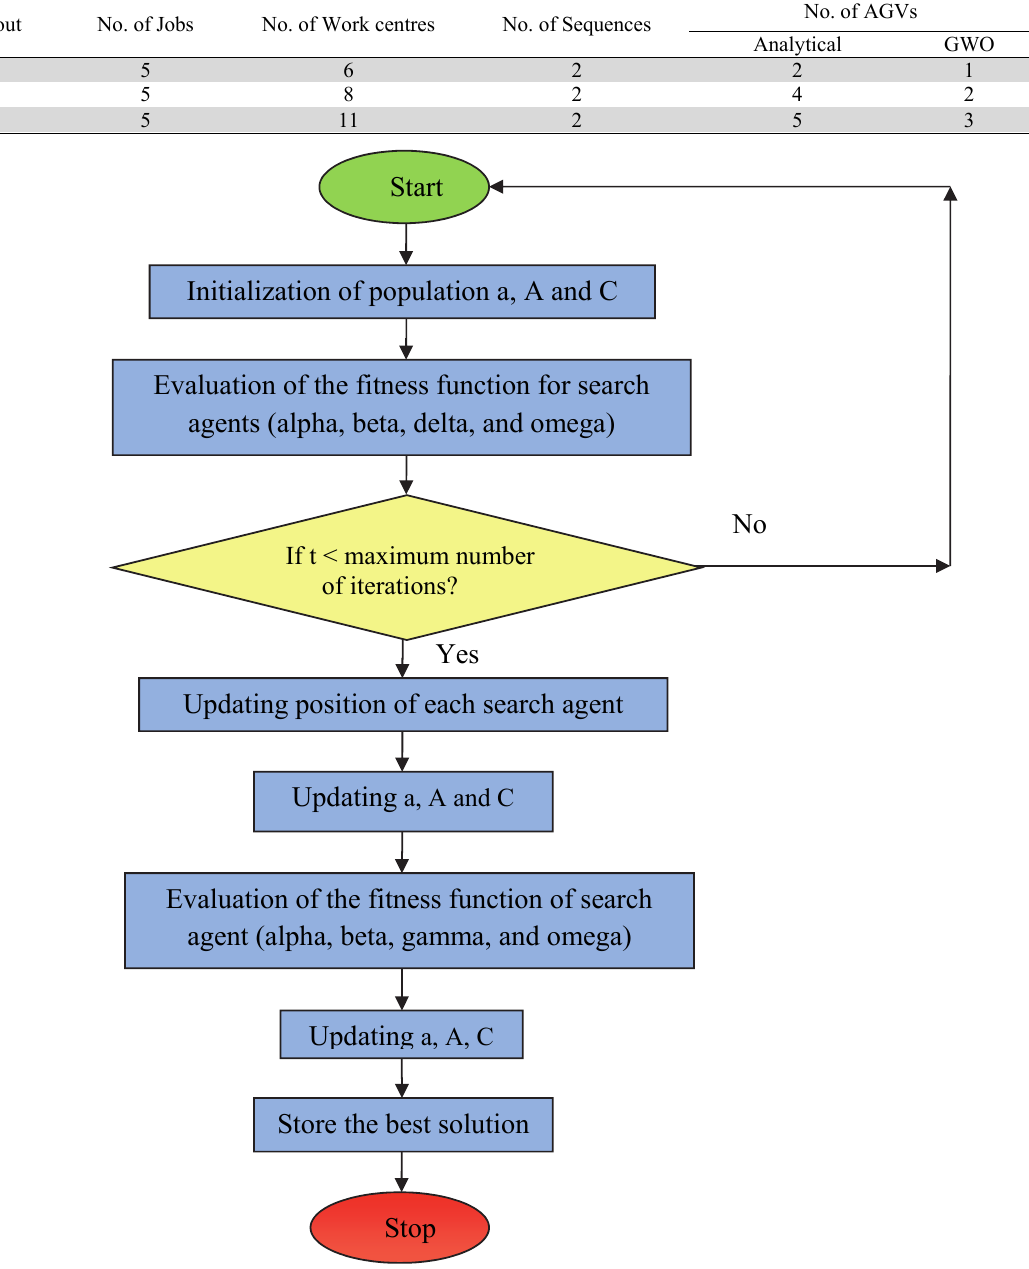
Fig. 1. Flowchart of grey wolf optimization